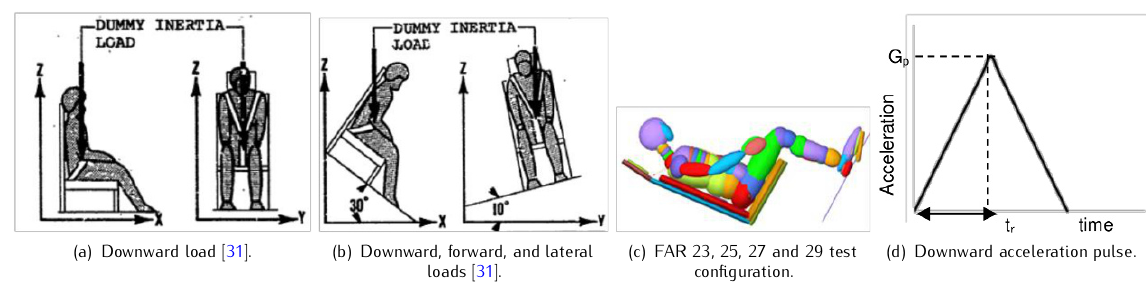
Figure 5. Military and FAR seat dynamic test configurations and acceleration input.